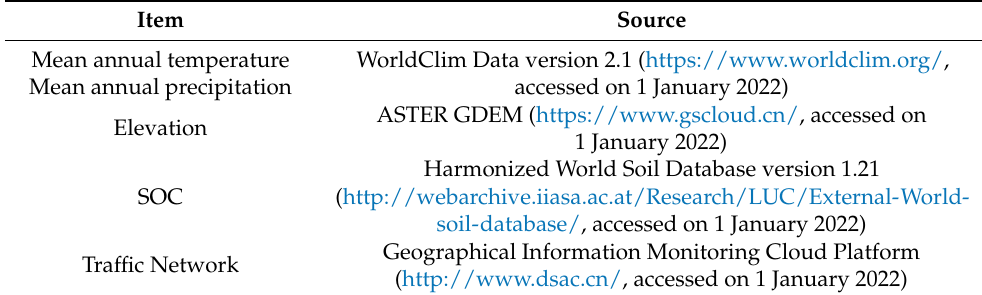
Table 1. Possible environmental and traffic network factors affecting invasive plant